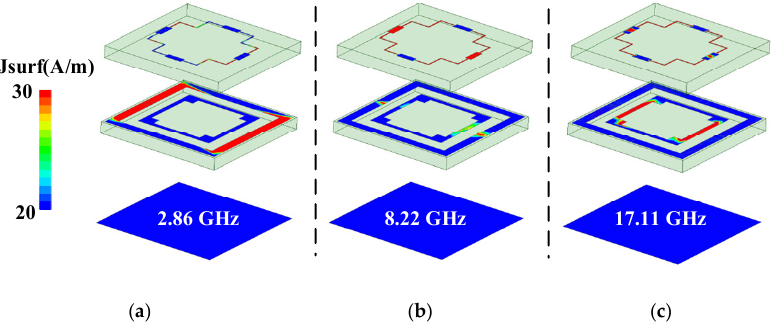
Figure 5. The surface current distribution at ( a ) 2.86 GHz, ( b ) 8.22 GHz, and ( c ) 17.11 GHz resonant points.